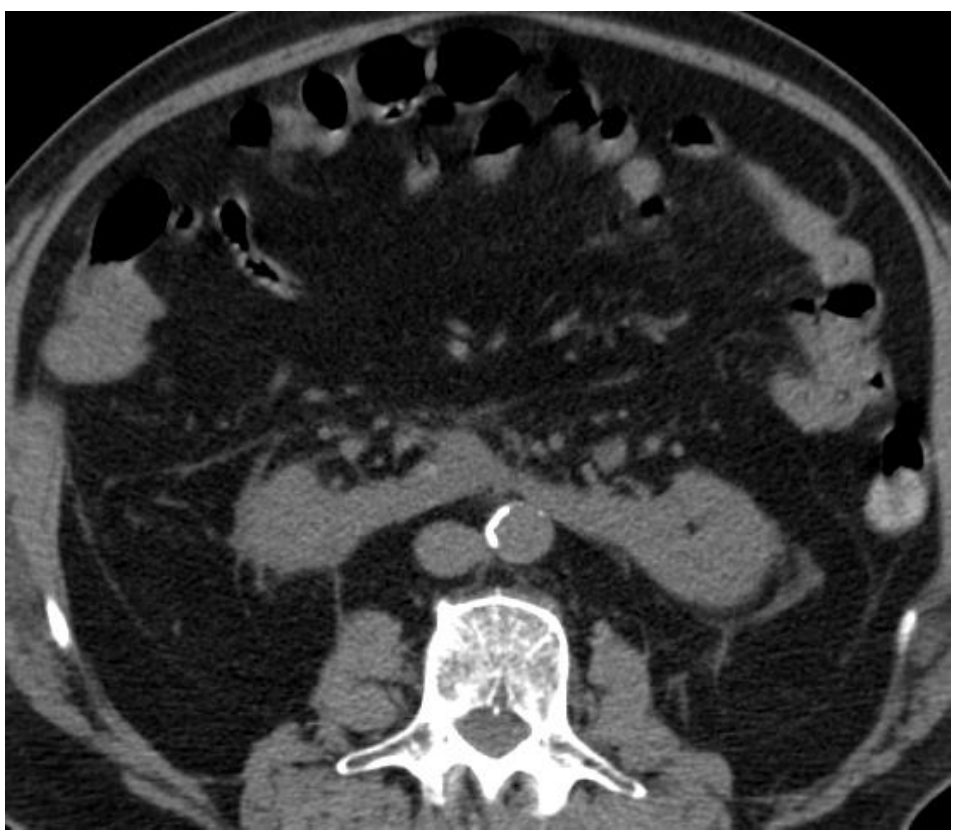
FIGURE 1. This transverse CT section of the abdomen shows complete fusion of the lower poles of the kidneys with a clear isthmus. The fused kidneys are sitting lower in the pelvis compared to the location of normal